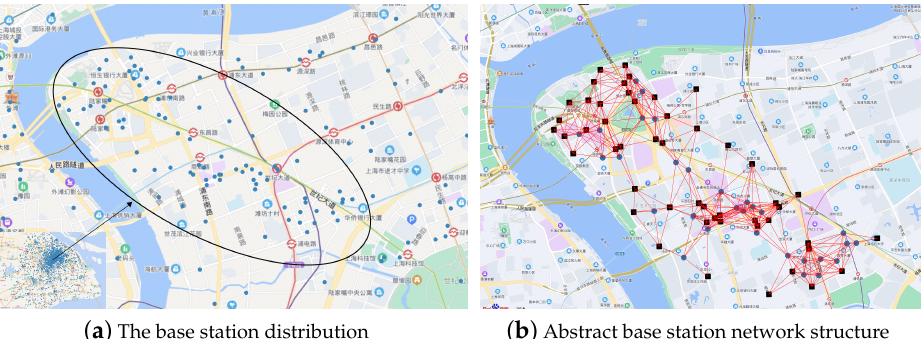
Figure 3. Pudong Central Business District (The blue dots in ( a ) represent base stations; Black squares in ( b ) indicate base stations, blue dots indicate network routers, and red lines indicate that devices can communicate with each